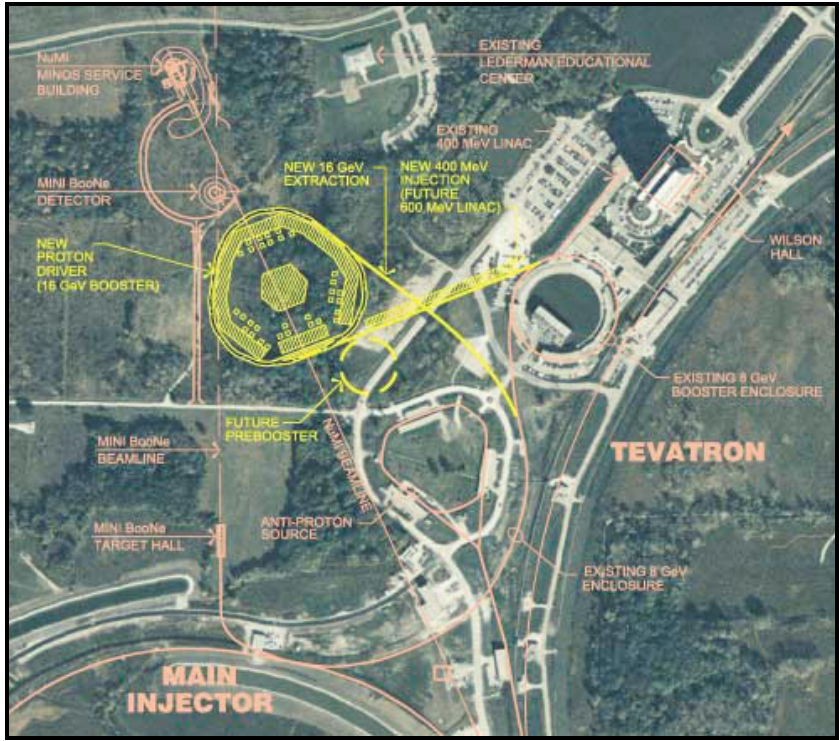
FIG. 13. (Color) FNAL proton driver layout from Ref. [125].